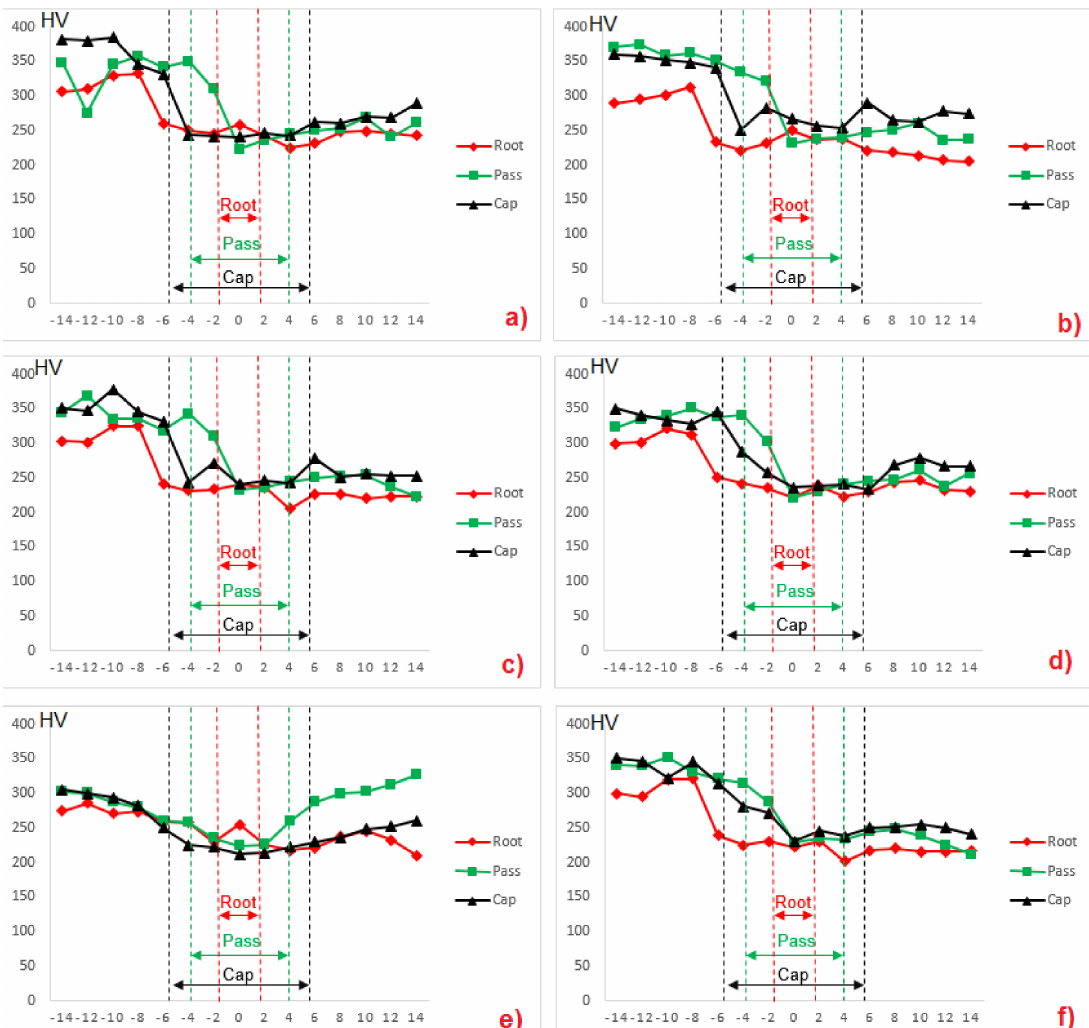
Figure 10. Micro hardness results for CCGTA welding employing ERNiCr-3 ( a ), TIG 316L ( b ), Twisted Filler ( c ), and PCGTA welding employing ERNiCr-3 ( d ), TIG 316L ( e ), Twisted Filler ( f